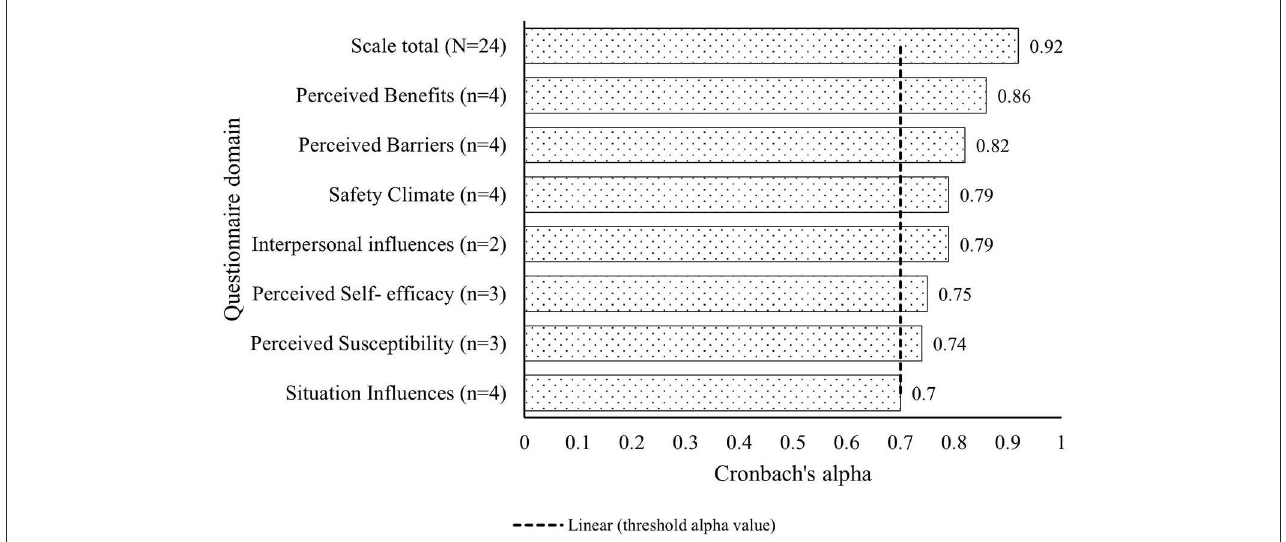
FIGURE3 Internal consistency of the items in the seven domains of the use of hearing protection devices questionnaire measured by Cronbach’s alpha coefficient. The vertical dotted line shows the threshold value of alpha coefficient for each domain and for the